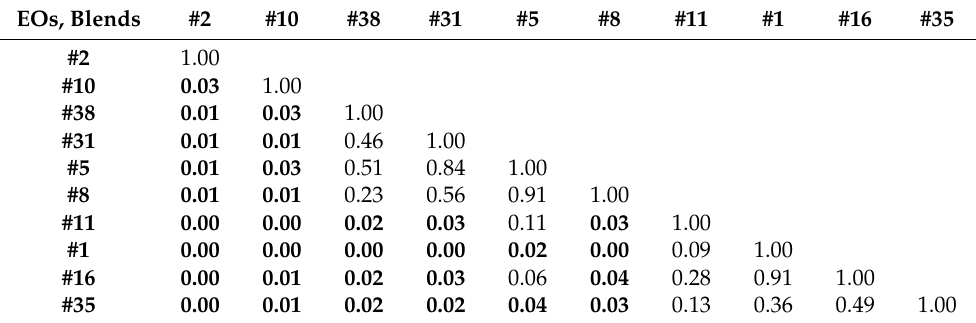
Table 2. Pairwise comparison ( t -test) of IC 50 values among the top-10 EOs blends with the highest inhibitory activity against the fish pathogen Aeromonas veronii bv. sobria . Statistically significant differences at p < 0.05 are highlighted in bold. The exact composition of each blend is shown in Table